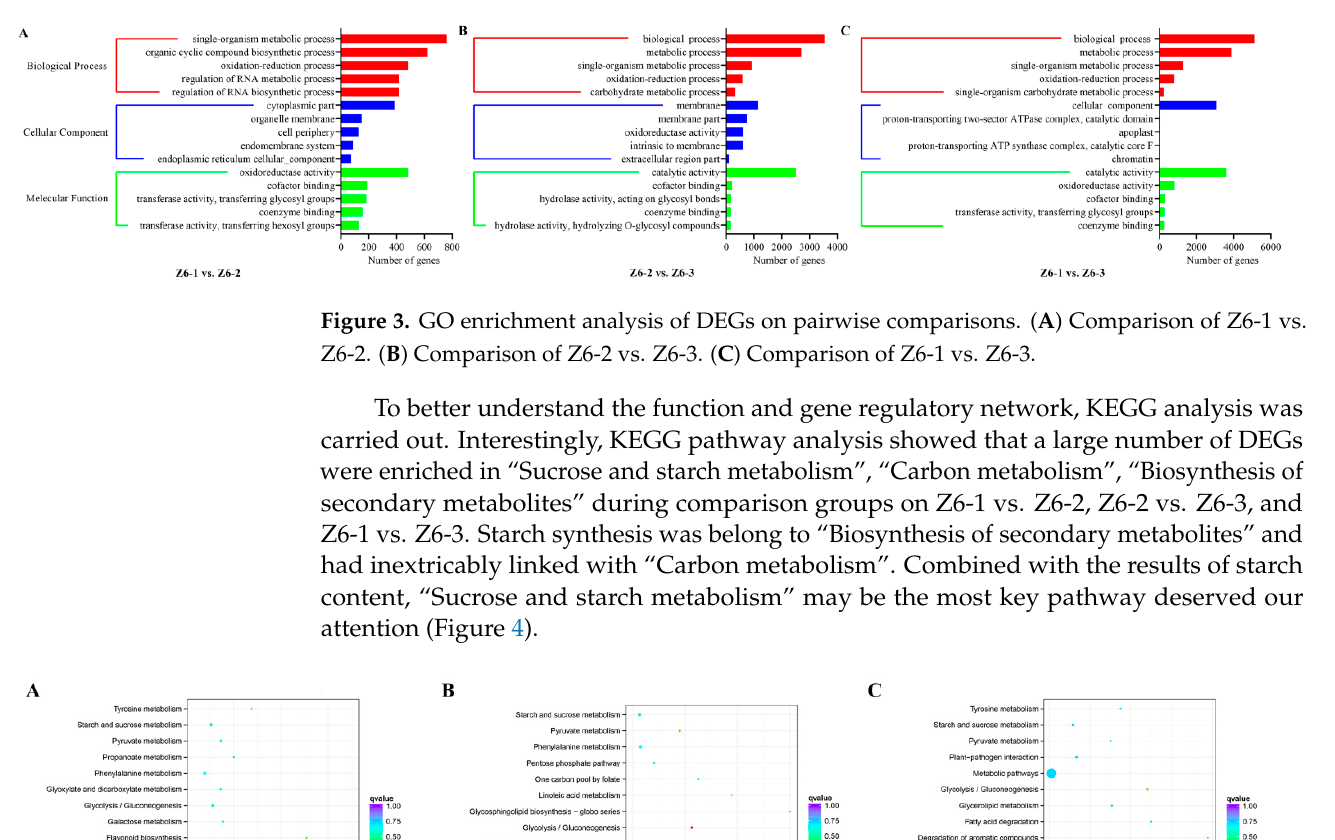
Figure 5. Expression profiles of starch biosynthetic genes. Green rectangles highlight genes down regulated from Z6-1 to Z6-3.